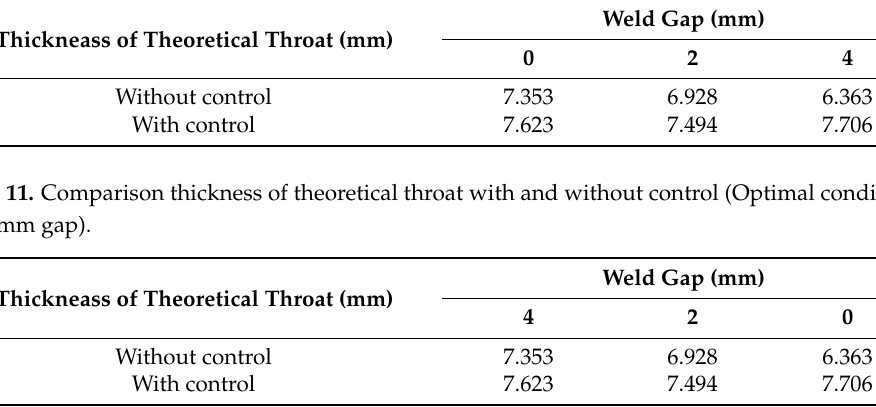
Table 10. Comparison thickness of theoretical throat with and without control (Optimal conditions for 0 mm gap).